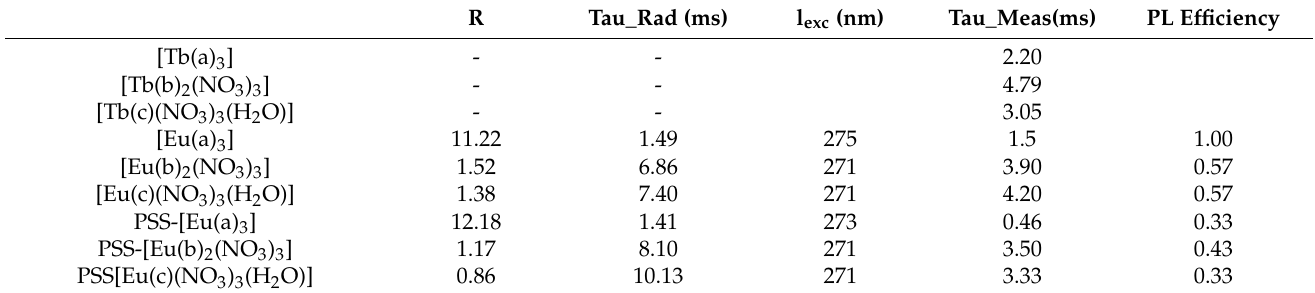
Table 1. Decay parameters and excitation wavelengths ( λ exc ) for [Eu( L ) x ] in CH 3 CN. R Tau_Rad (ms) l exc (nm) Tau_Meas(ms) PL